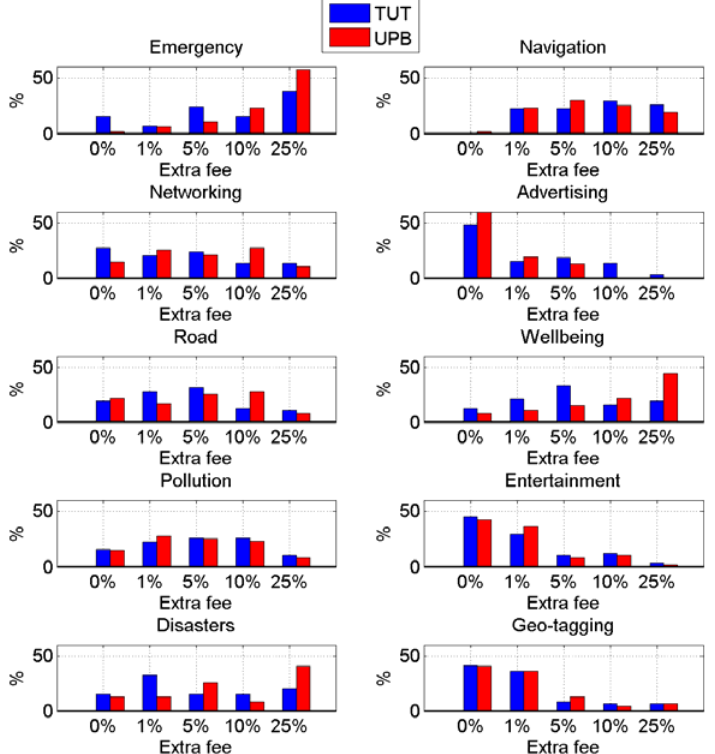
Figure 6. Histograms of preferences about possible LBS on personal mobile phones, measured as willingness to pay an extra monthly